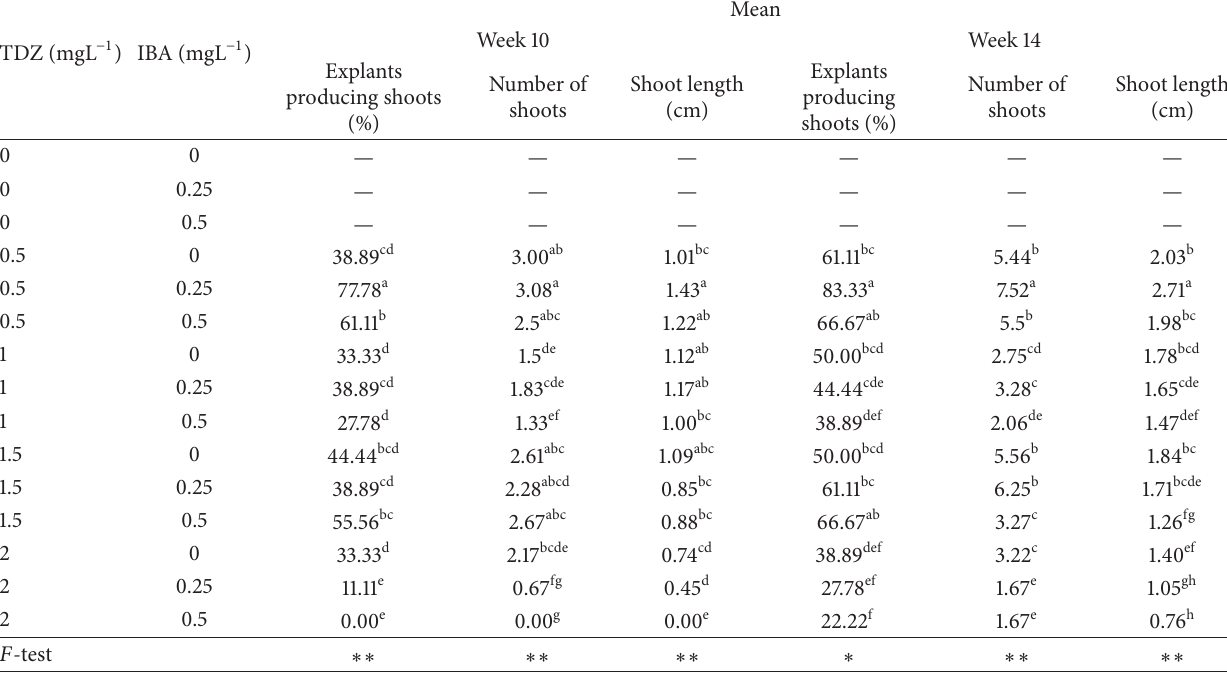
Figure 1: In vitro propagation of C. latifolia. (a) Shoot meristem and lateral bud grown after four weeks on MS medium supplemented with T0.5I0.25; (b) adventitious shoots have emerged after eight weeks; (c) development of shoots from shoot tip after 10 and (d) 14 weeks of culture. Table 1: Effect of different concentration of TDZ and IBA on percentage of explants producing shoots, shoot numbers, and shoot length after 10 and 14 weeks of